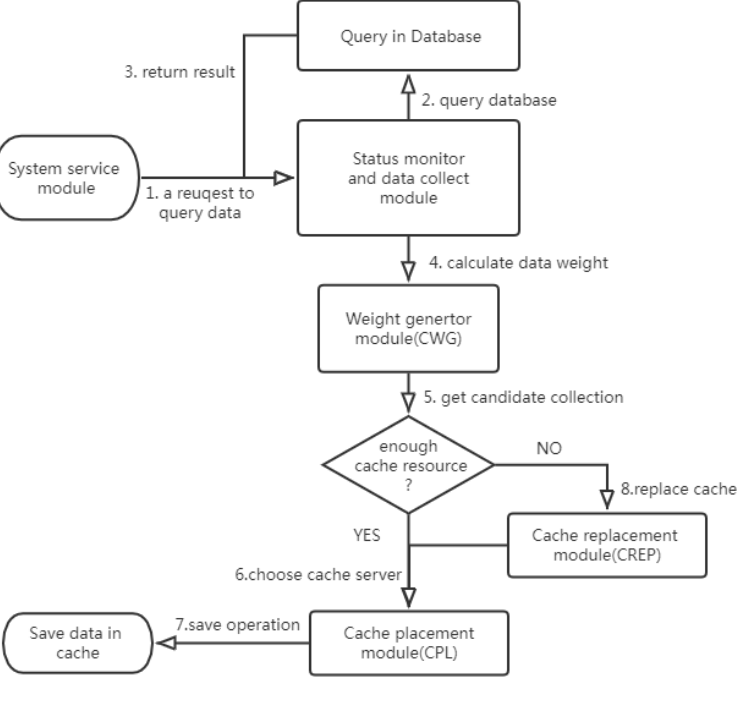
Figure 4. The flowchart of